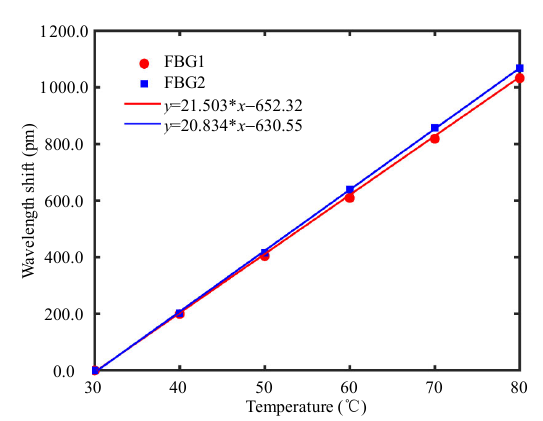
Fig. 14 Temperature responses of the tilt sensor. Table 3 Performance comparison of FBG tilt